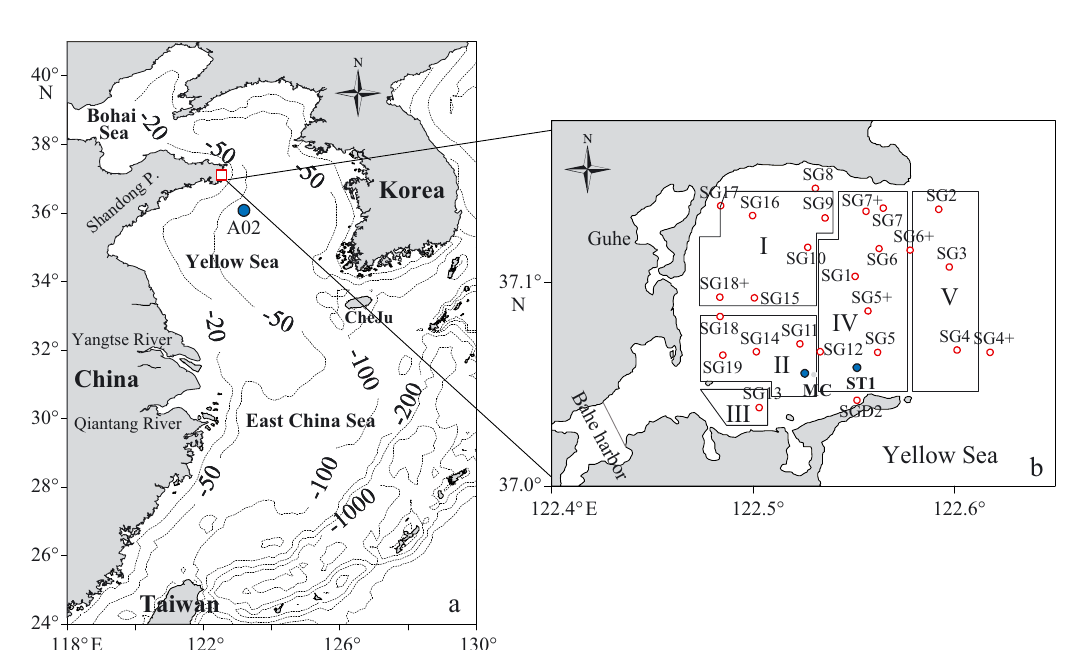
Fig. 1. Study area. (a) East China marginal seas and the location of Sanggou Bay (SGB, inside the red rectangle). (b) Maricul- ture areas and sampling stations in SGB. (I) scallop monoculture, (II) oyster monoculture, (III) fish monoculture, (IV) scallop/ kelp polyculture, and (V) kelp monoculture. Filled circles represent core sediment sampling stations, and open circles represent surface sediment sampling